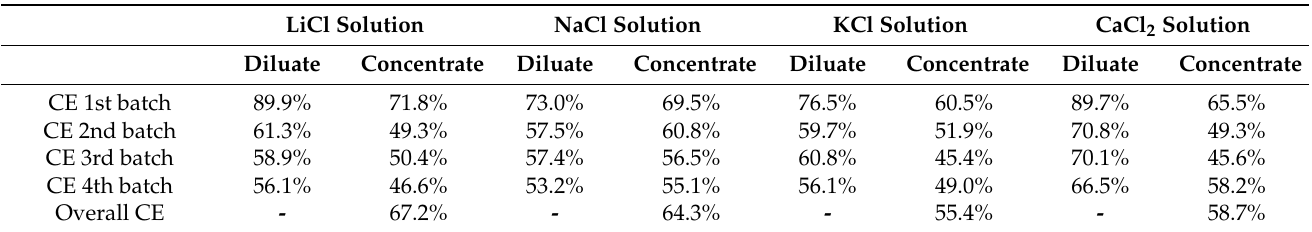
Table 3. Comparison of water transport through the membranes depending on the cation; investi- gations conducted at 20 V for concentrations for Cl - ions of 0.024 mol/L at ϑ = 21 °C (cation molar concentration adjusted accordingly).